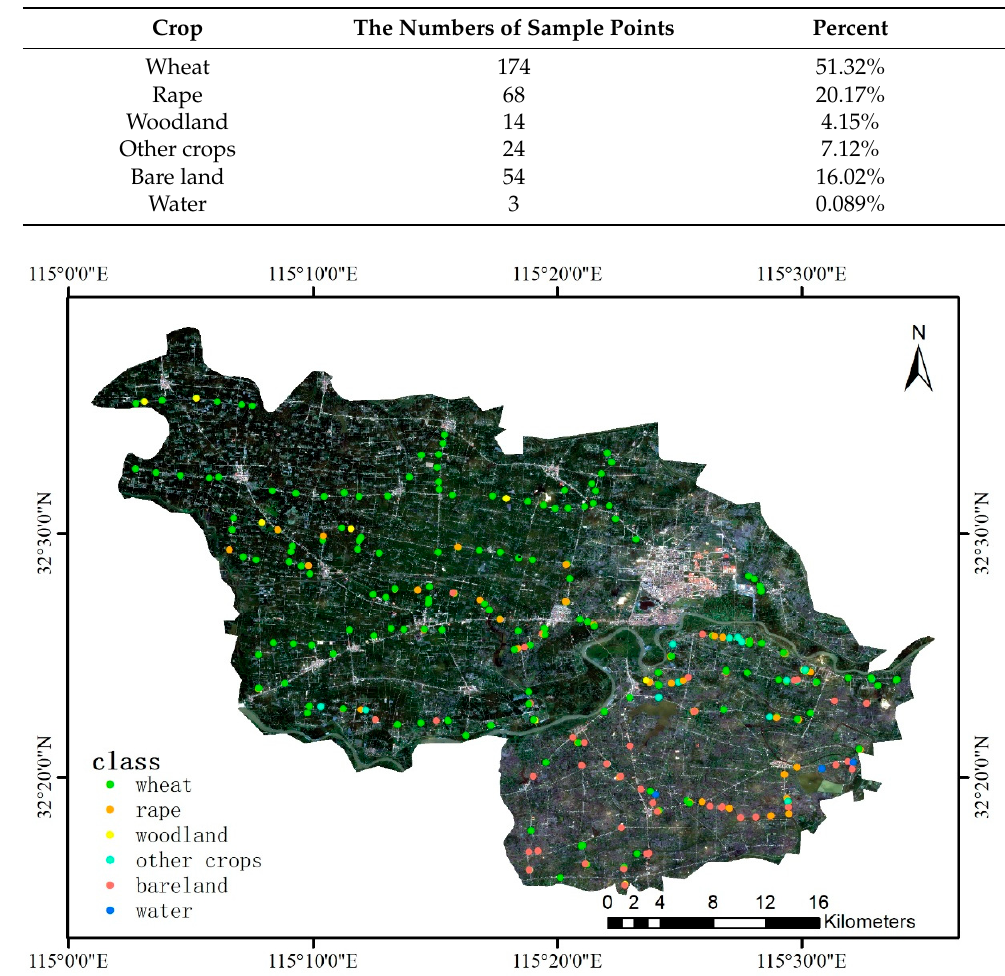
Table 2. The number of sample points.